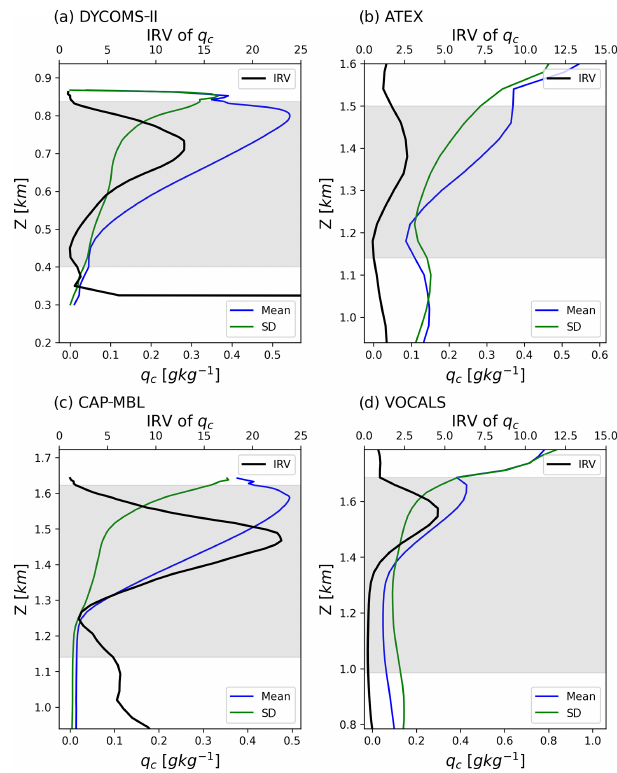
Figure 11. Vertical profiles of the horizontally averaged mean, standard deviation, and inverse variance of q c (same as Fig. 7a) but for four other LES cases from previous studies: (a) DYCOMS-II RF02, (b) ATEX, (c) CAP-MBL, and (d) VOCALS.